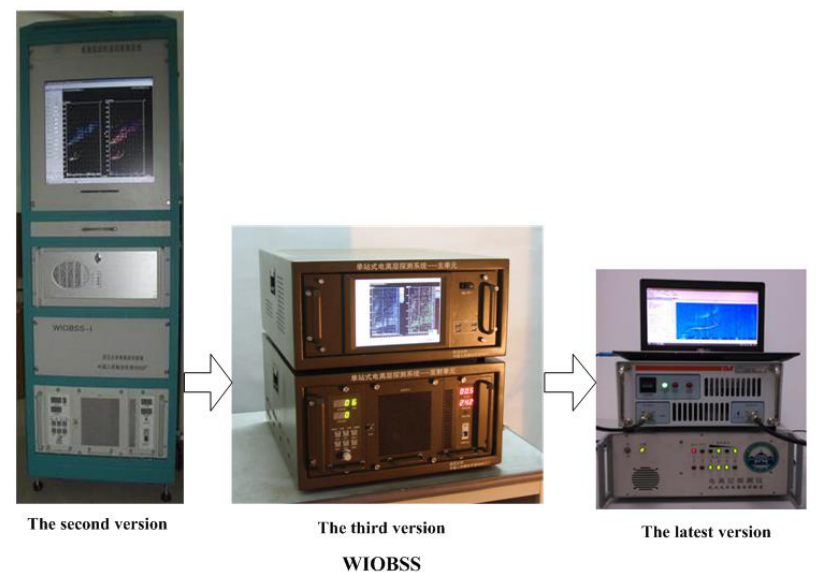
Figure 4. Evolution of WIOBSS over three decades.